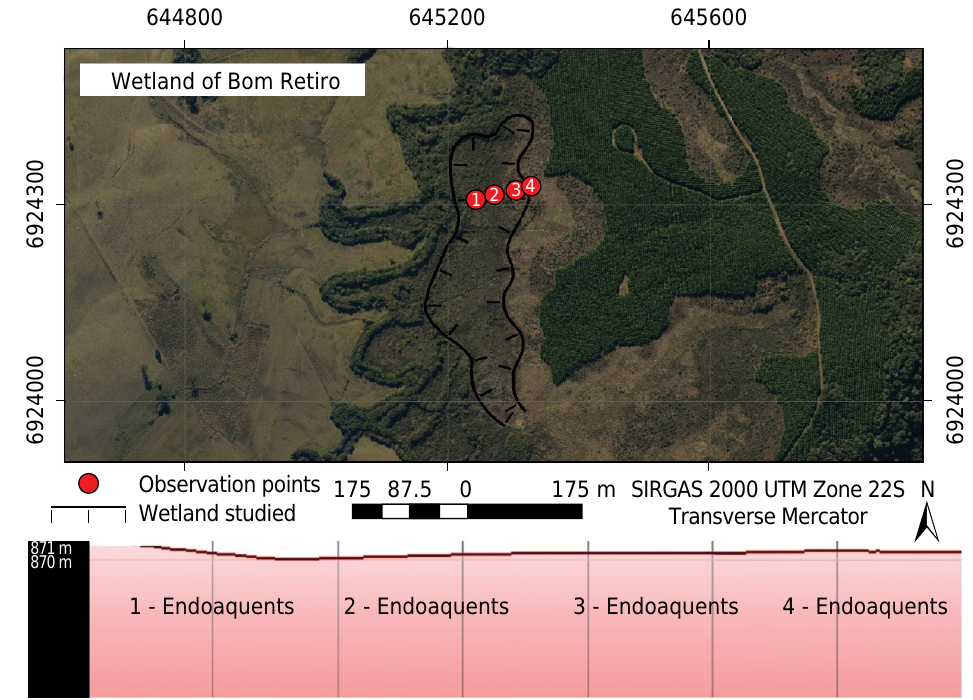
Figure 5. Location of the wetland in the municipality of Bom Retiro (BR), SC, and elevation profile. Distance between points 1 and 2: 12 m; 2 and 3: 25 m; 3 and 4: 17 m. Figure of the Aerophotogrammetric Survey of the State of Santa Catarina, Brazil, 2010.